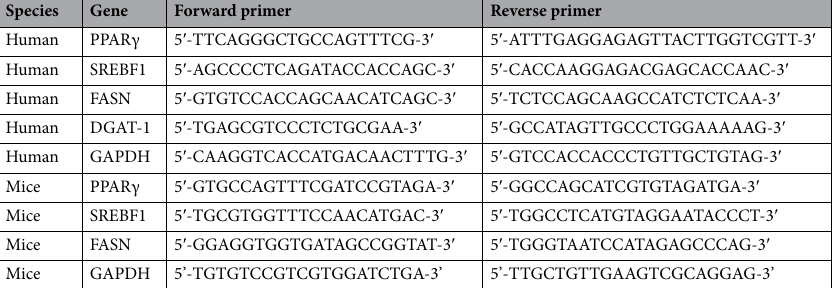
Table 1. Primer sequences used for real-time quantitative